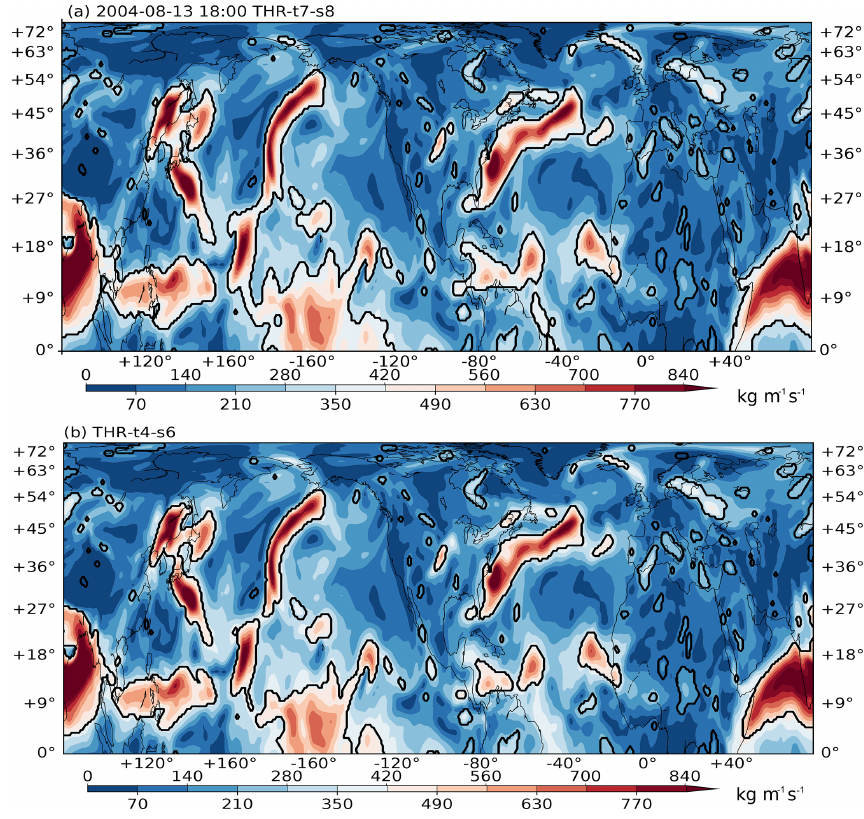
Figure A4. Northern Hemisphere IVT distribution on 13 August 2004 at 18:00UTC. Black contours denote connected regions where the THR anomalies are greater than zero. Panel (a) shows the result using THR-t7-s8 parameters; (b) shows the THR-t4-s6